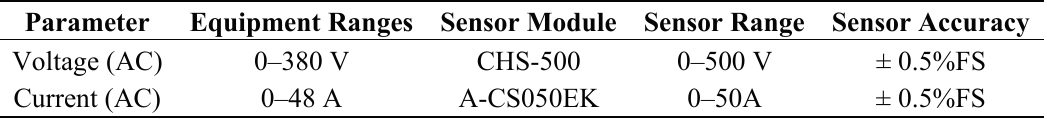
Table 1 lists the monitoring parameters of key points and requirement for sensors scale and precision. Table 1. The well mining equipment monitoring